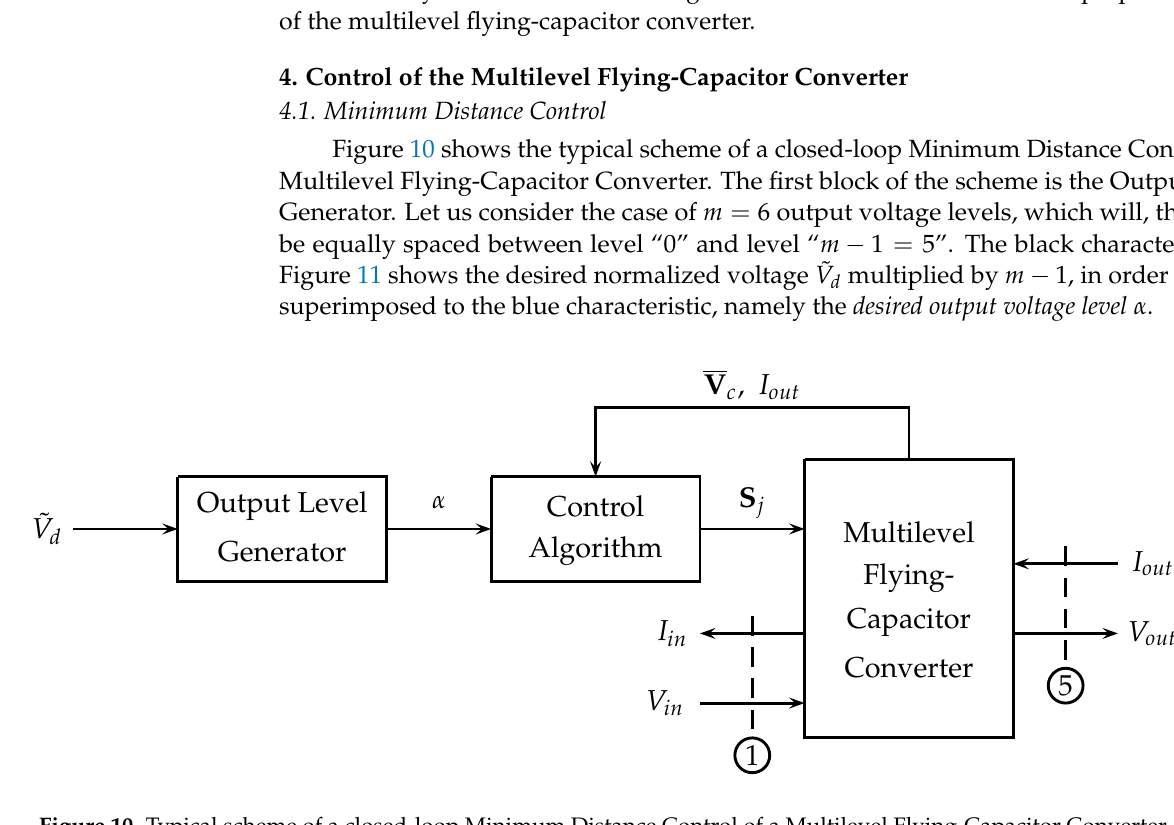
Figure 10. Typical scheme of a closed-loop Minimum Distance Control of a Multilevel Flying-Capacitor